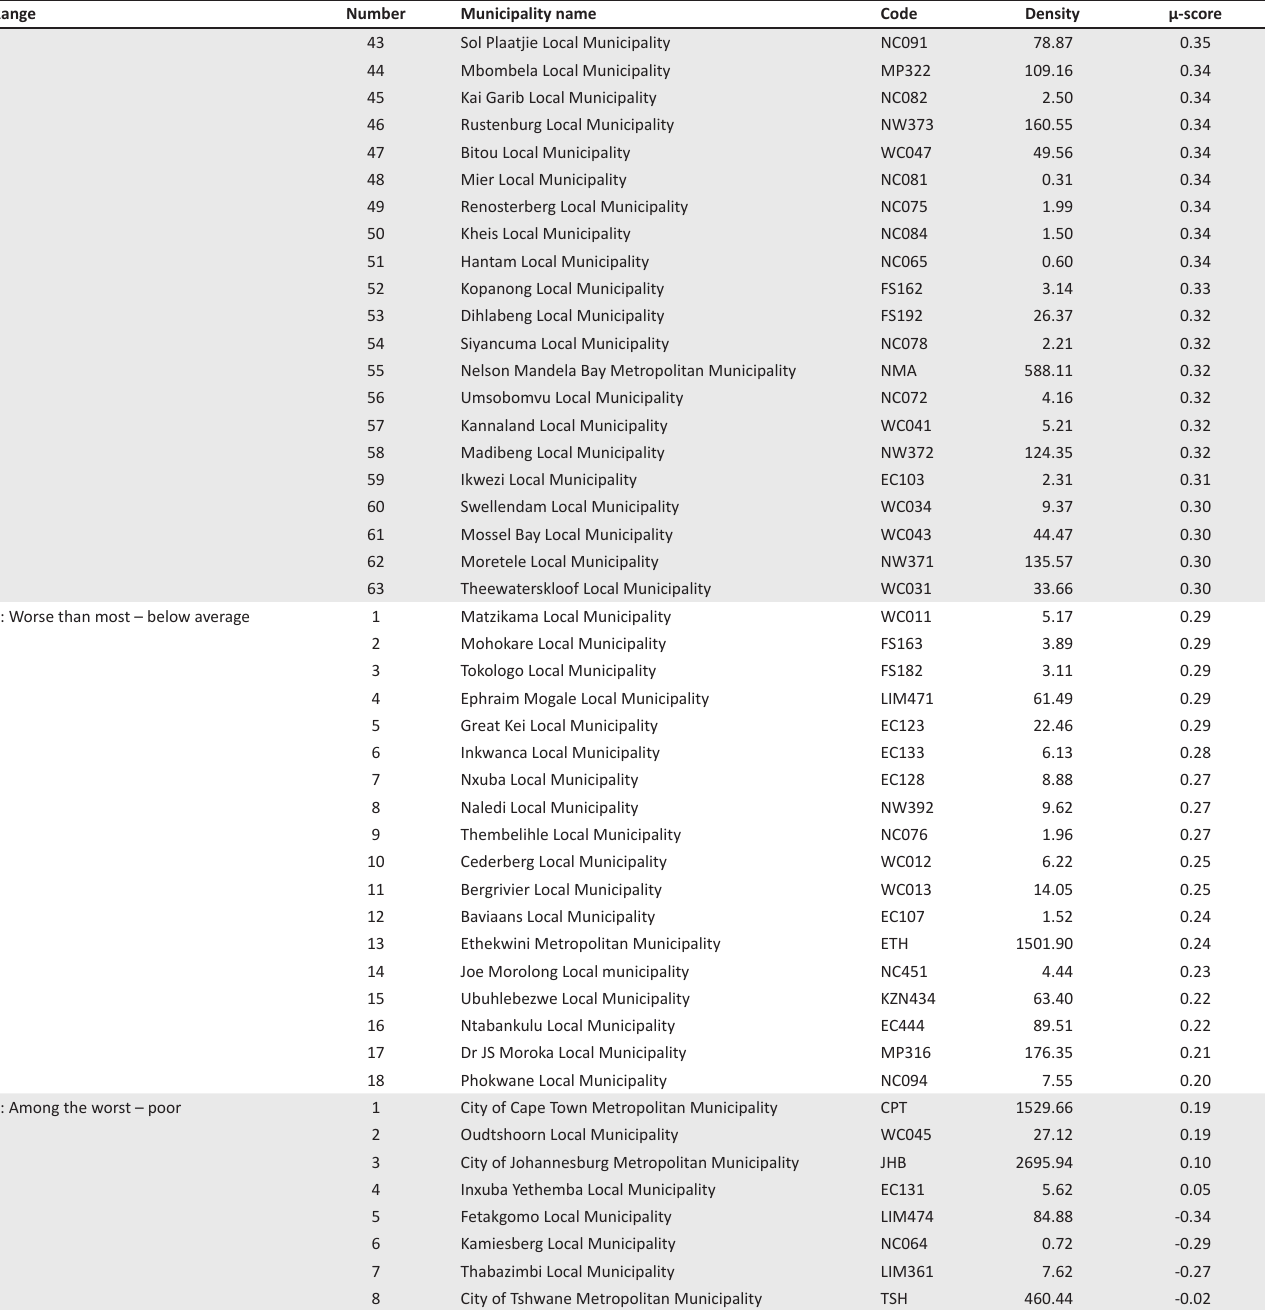
TABLE 1-A1 (Continues...): Financial condition scores by rank.